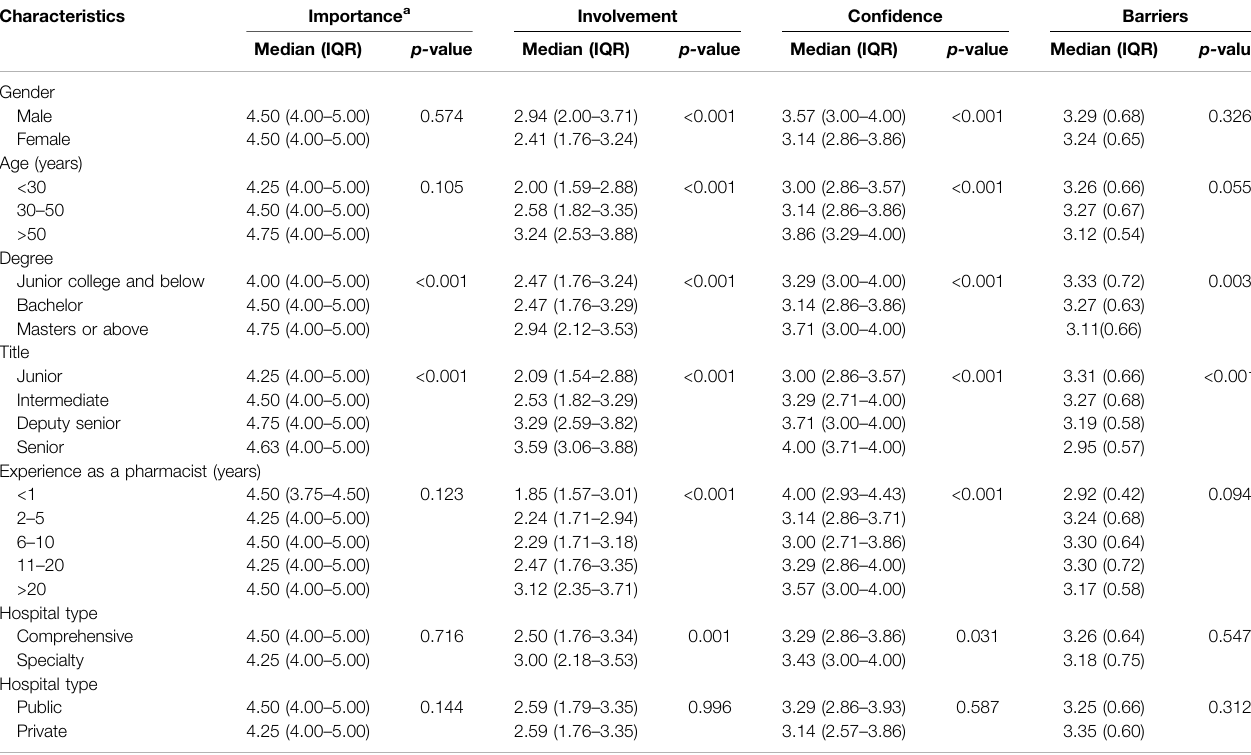
TABLE 4 | Median scores of pharmacists rating their involvement and perception in AMS activities based on